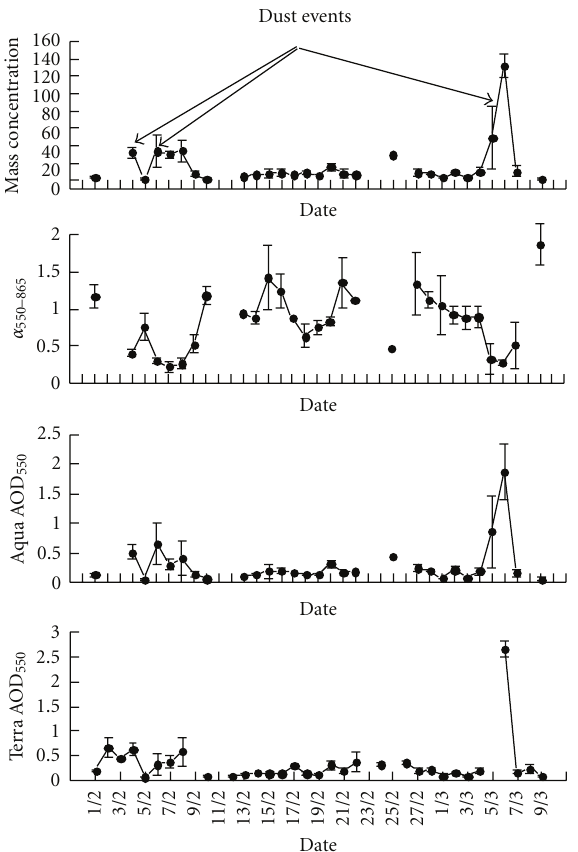
Figure 6: Daily time series of mass concentration, α 550–865 and AOD 550 from Terra and Aqua-MODIS sensors during the period February 1, 2009 to March 10, 2009, averaged over the area 37.0 ◦ –38.5 ◦ N and 23.0 ◦ –24.5 ◦ E.